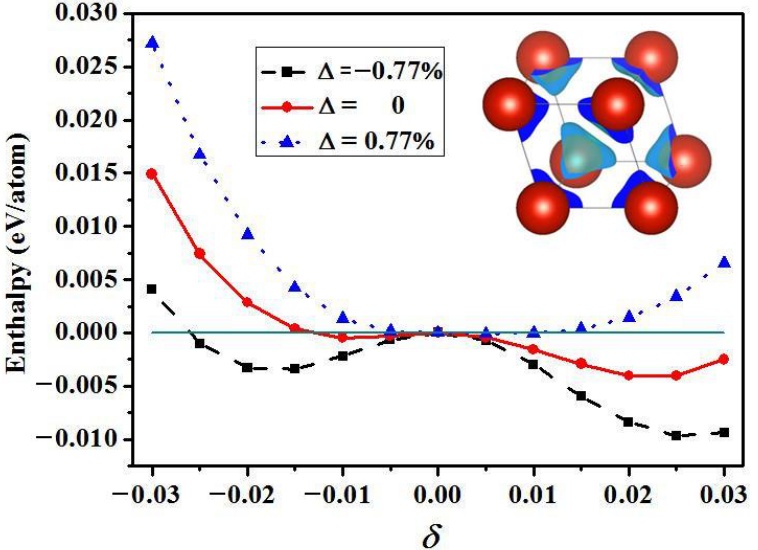
Figure 2. Calculated enthalpy difference with respect to BCC phase as a function of the RH deformation parameter δ when the Fermi level is shifted up or down at a pressure of 211 GPa. Inset: Calculated differential charge density between ∆ = − 0.77% and ∆ = 0. (By the courtesy of Ref. [54]).